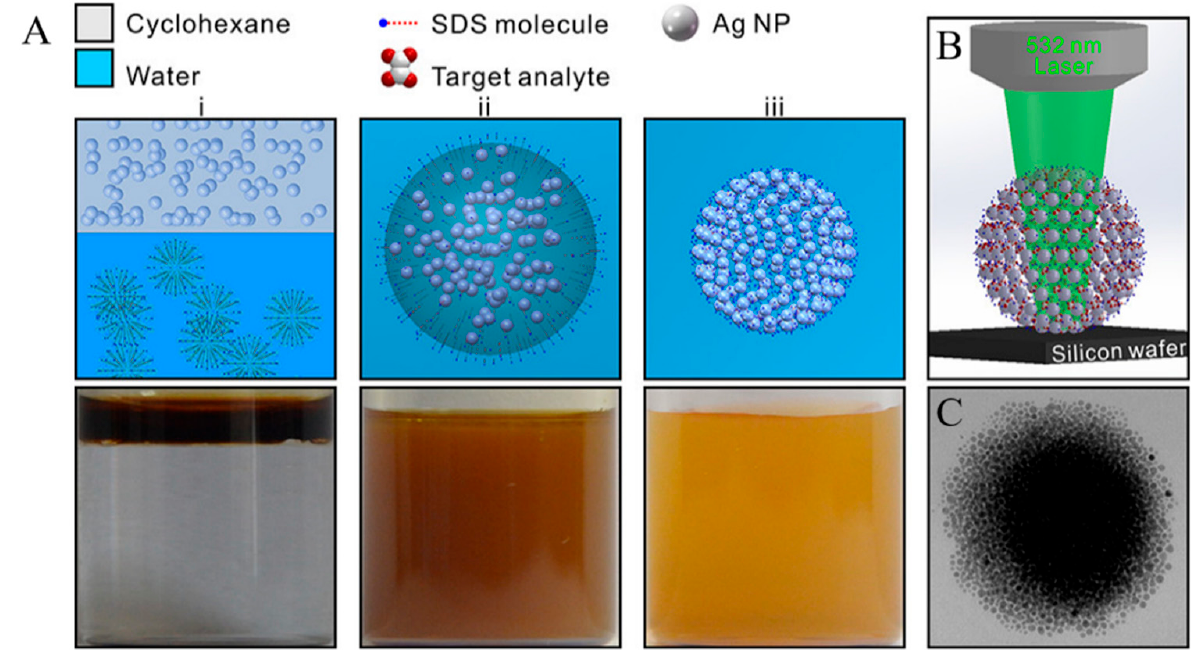
Figure 6. ( A ) Schematic and the corresponding optical images of the self-assembly of Ag NPs into spherical Ag colloidal superstructures. (i) The addition of CYH-dispersed Ag NPs into SDS aqueous phase. (ii) An oil-in-water emulsion through vigorous stirring. (iii) The as-prepared sols of spherical superstructures after the evaporation of oil. ( B ) Schematic of SERS platform for sensing